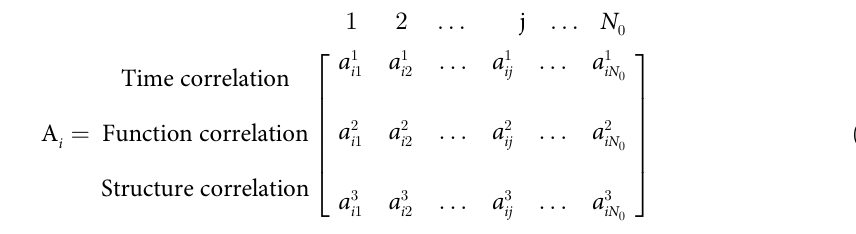
: Unit labour cost C p